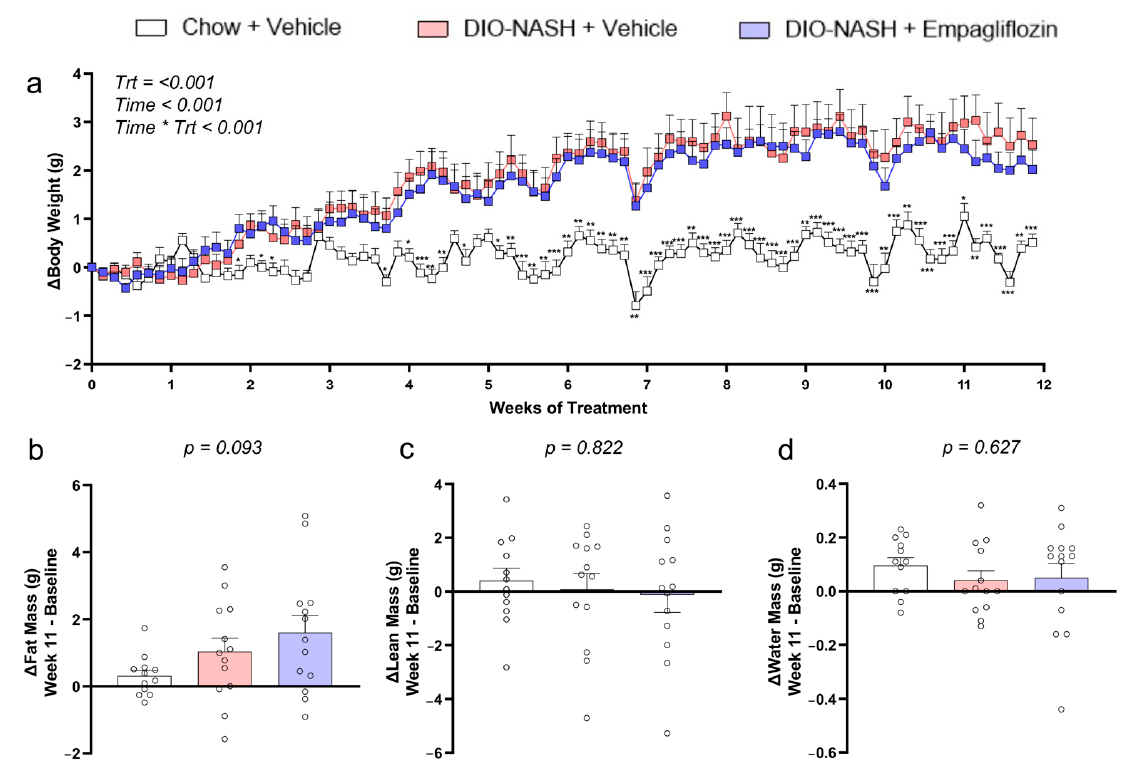
Figure 1. Empagliflozin does not affect the body weight and body composition in DIO ‐ NASH mice. ( a ) Changes in body weight, ( b ) fat mass, ( c ) lean mass and ( d ) water mass during the 12 weeks of treatment. A mixed ‐ model analysis was performed for the changes in body weight and p ‐ values are reported for Trt, treatment (Chow + vehicle, DIO ‐ NASH + vehicle, DIO ‐ NASH + empagliflozin), Time (day of treatment) and their interaction Time * Trt. A one ‐ way ANOVA was performed for ( b – d ) and p of the ANOVA is reported. Data show means ± SEMs. Δ refers to a change at that timepoint compared with the baseline (treatment start). Ν = 12 for Chow + vehicle and n = 13 for DIO ‐ NASH + vehicle and DIO ‐ NASH + empagliflozin.